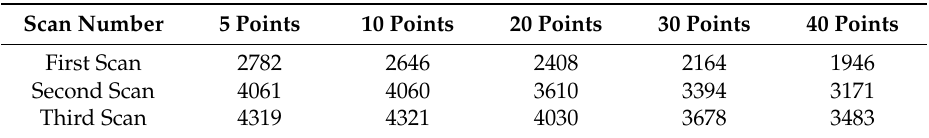
Table 2. Number of occupied voxels in each scan for different numbers of points within an occupied voxel.